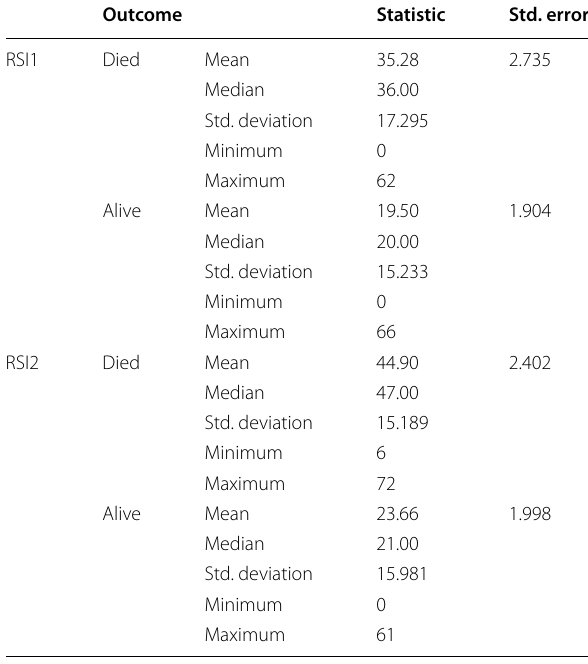
Table 2 Description of chest X-ray RSI1 and RSI2 to outcome